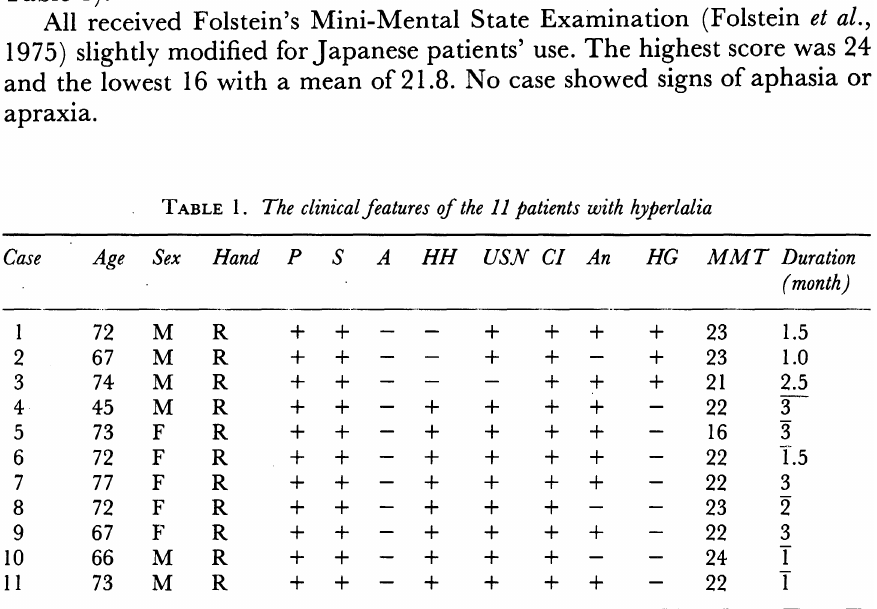
TABLE 1. The clinical features of the 11 patients with